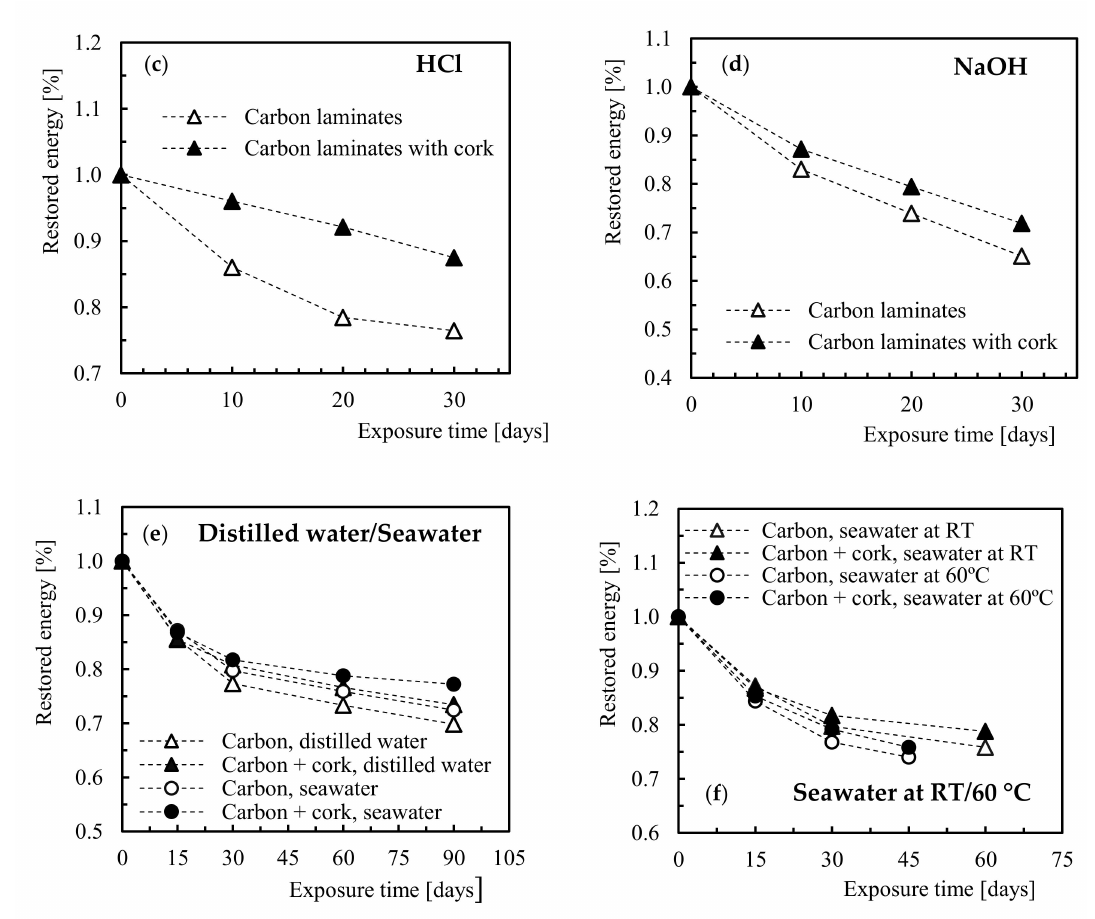
Figure 6. Influence of solution type and exposure time on the restored energy after immersion into: ( a ) diesel; ( b ) H 2 SO 4 , ( c ) HCl, ( d ) NaOH, ( e ) distilled water and seawater; ( f ) seawater at room temperature and at 60 ◦